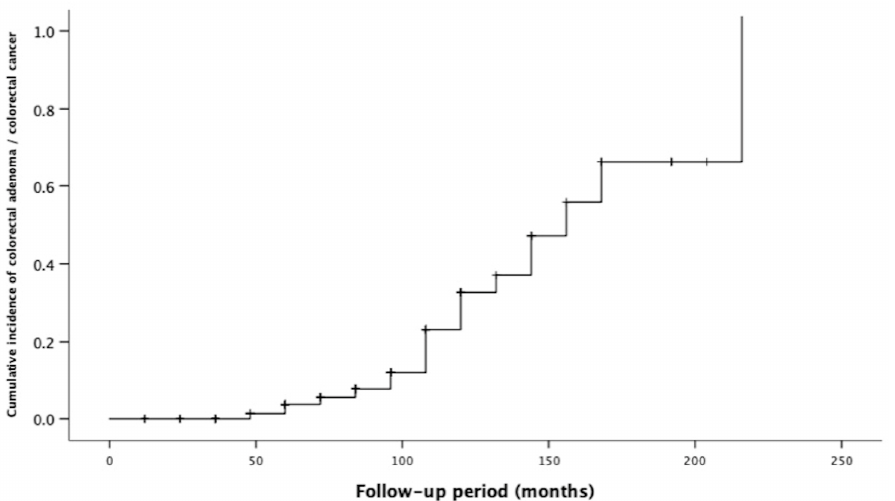
Figure 1. Kaplan–Meier analysis on the cumulative risk of overall colorectal adenoma according to the time from kidney transplantation.